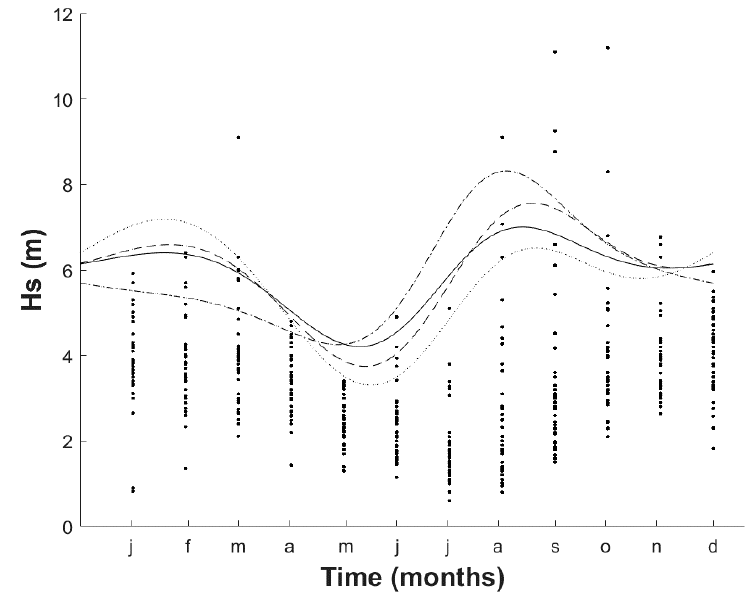
Figure 1. Monthly maximum and 30-yr return period values of Hs using different time ranges.